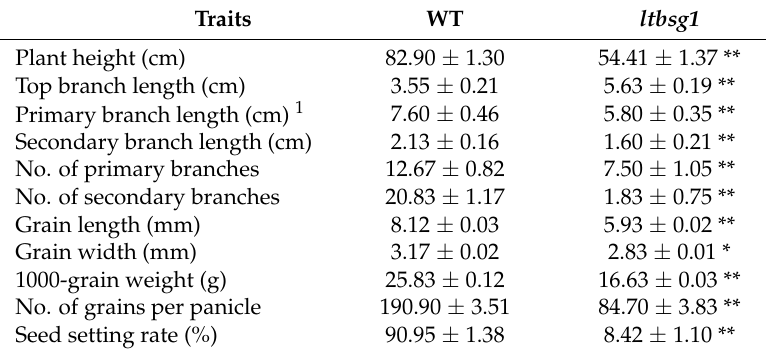
Table 2. Agronomic traits of WT and mutant ltbsg1